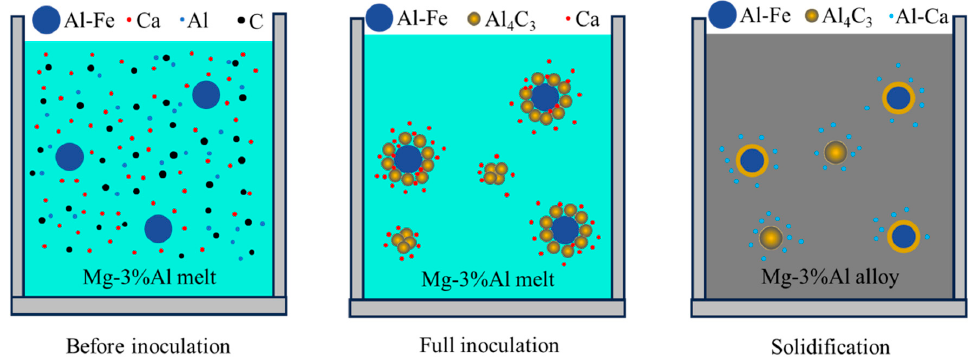
Figure 5. Schematic diagrams of the formation process of the duplex-phase and Al 4 C 3 cluster particles.